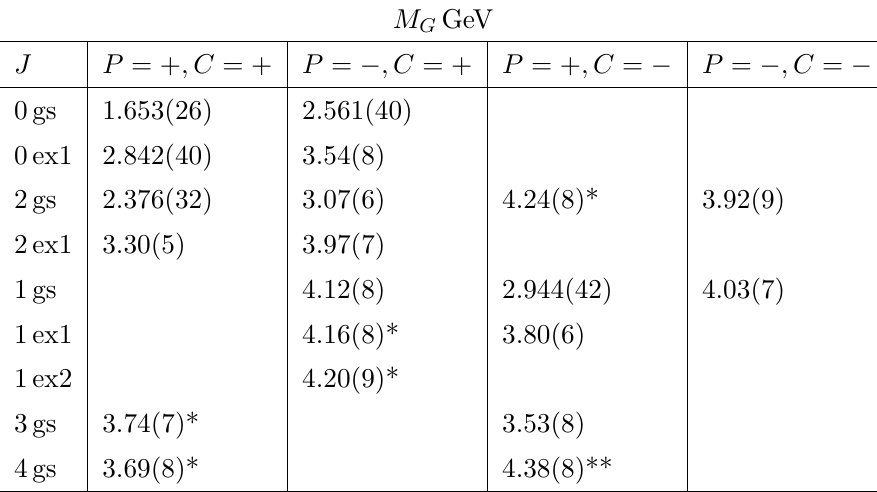
Table 18 . Glueball masses in physical GeV units using r 0 = 0 . 472(5) fm. For those glueballs whose J PC we can identify. Ground state denoted by gs , i ’th excited state by exi . Stars denote a level of uncertainty as in table 2. Errors are statistical